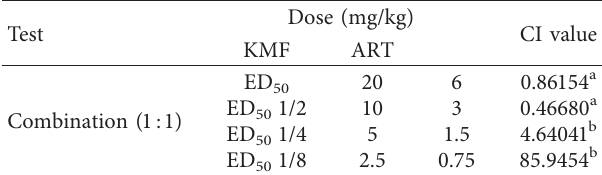
Figure 2: Antimalarial activity of combination treatment against PbANKA-infected mice. Groups of ICR mice (5 mice of each) were inoculated with 1 × 10 7 parasitized erythrocytes of PbANKA by IP injection. They were then given the combination drugs of ART and KMF atthe doses of their respective ED50 and fixed-ratio combination (1:1) of their respective ED50 of 1/2, 1/4, and 1/8. The treatment was carried out once a day for 4-consecutive days (D0–D3). Parasitemia was subsequently estimated on D4. ∗∗∗ P < 0 . 001, compared to the untreated group. # P < 0 . 05 and ## P < 0 . 01, compared to 6ART. UN: untreated group; 20KMF: 20mg/kg of kaempferol; 6ART: 6mg/kg of artesunate. Results were shown as mean ± SEM. Table 1: Combination index values of the combination of arte- sunate and kaempferol against Plasmodium berghei ANKA-in- fected mice.